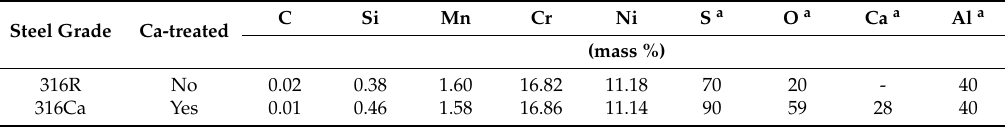
Table 1. Composition of samples of the reference steel (316R) and the Ca-treated steel